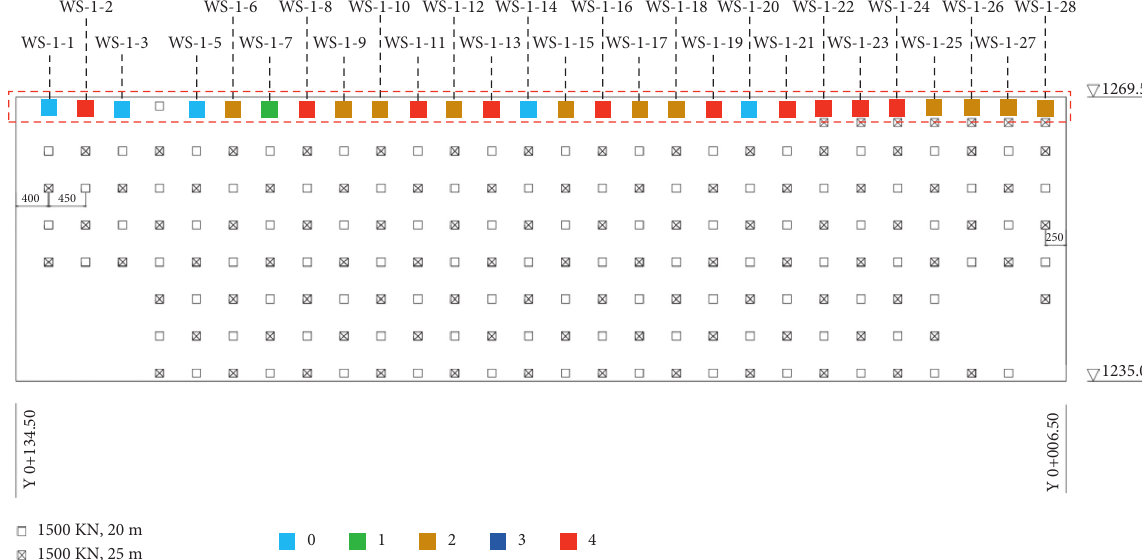
Figure 13: Distribution of corrosion degrees of anchor heads on the upstream sidewall of tailrace surge chamber.